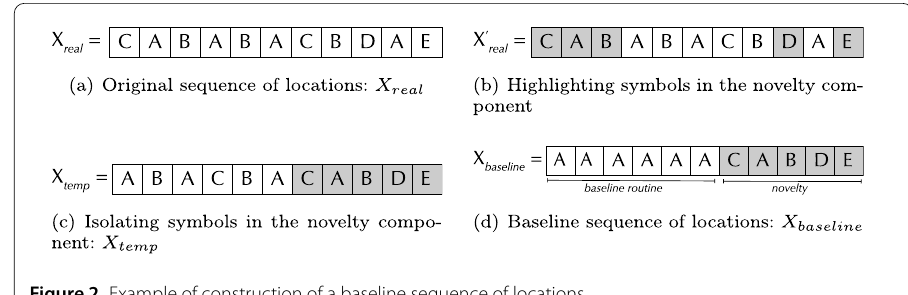
Figure 2 Example of construction of a baseline sequence of